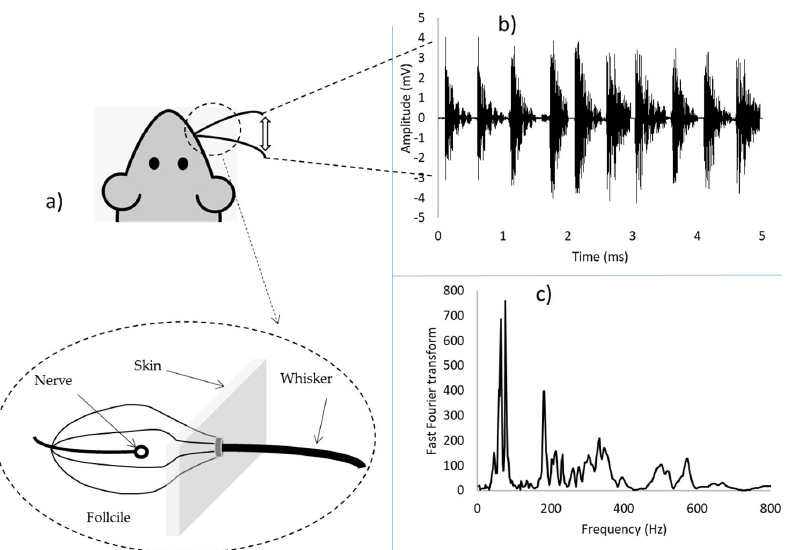
Figure 5. ( a ) Schematic of the whisker sensor, ( b ) Typical transient signals obtained from the whisker sensor, and ( c ) representation of a signal after applying fast Fourier transform analysis.